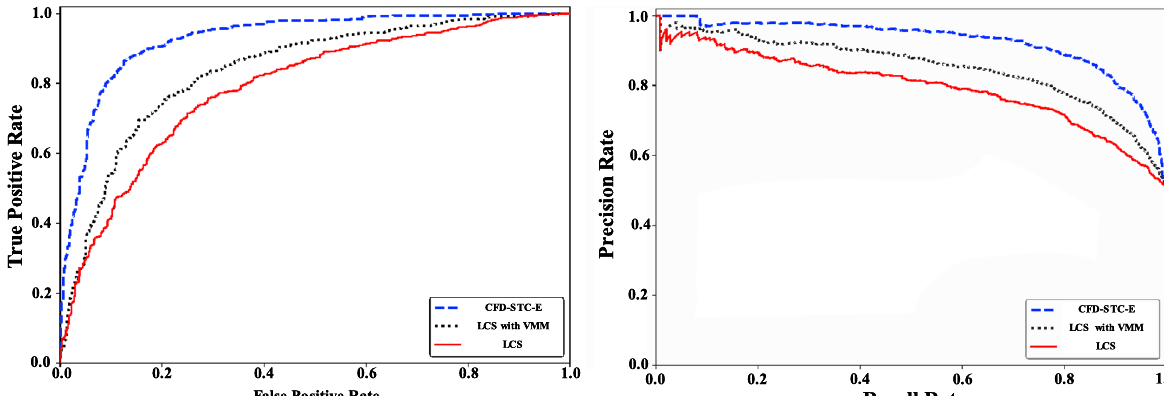
Fig. 15 Comparison of ROC and P-R curves of the two